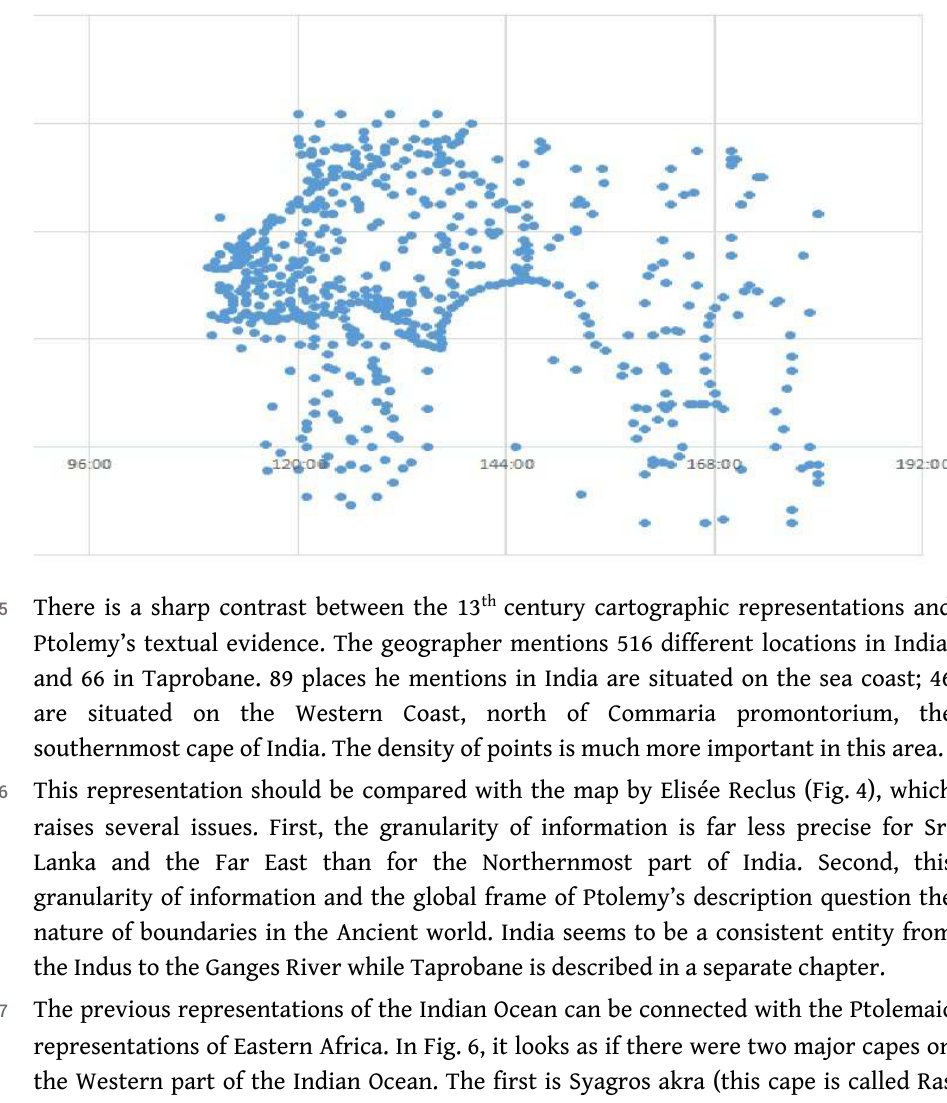
Figure 5. Data of the Indian Ocean represented by